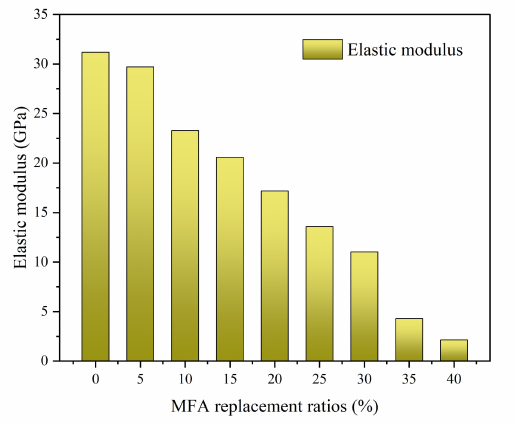
Figure 9. Elastic modulus versus MFA replacement ratios.